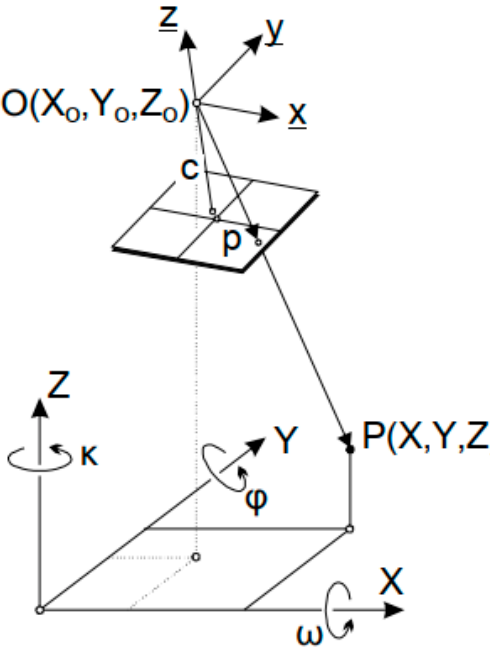
Figure 17. Collinearity condition in the 3D space. Our localization module uses the camera’s intrinsic matrix and its lens distortion parameters, obtained through camera calibration (see Section 7.1.2), which were not con- sidered in